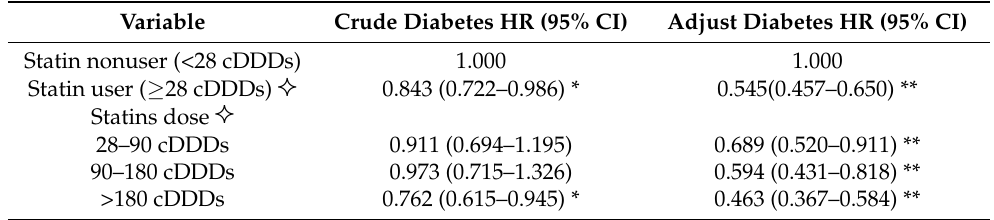
Table 2. Hazard ratios of incident diabetes mellitus between statin users and nonusers with transient ischemic attack.